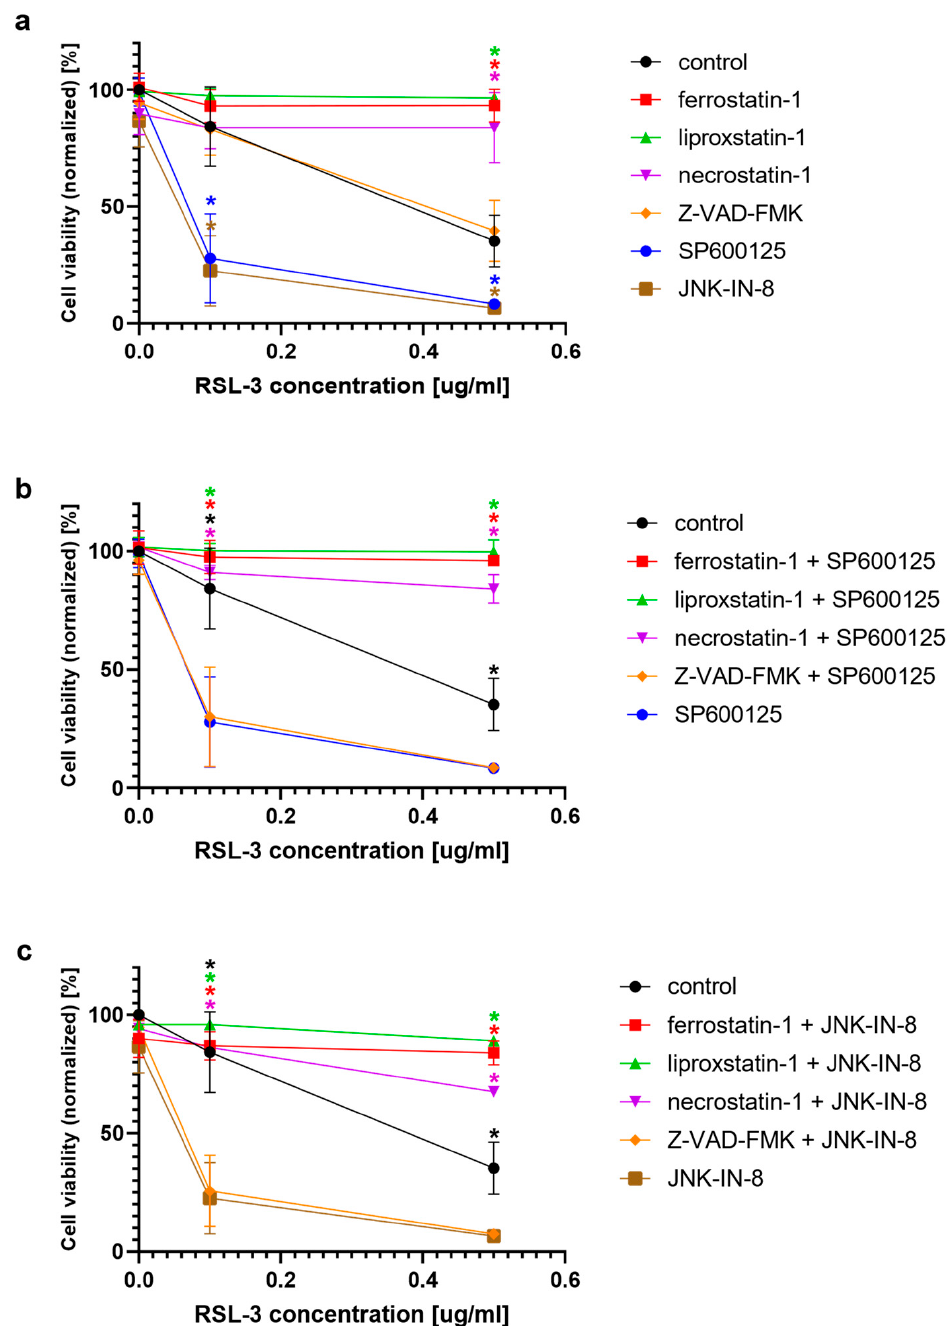
Figure 2. The potential effect of the inhibitors in alleviating cell death induced by RSL-3 in the presence or absence of the JNK inhibitors. HT-1080 cells were treated on a 96-well plate for 24 h with the ferroptosis-inducing compound RSL-3 (0.1 µ g/mL and 0.5 µ g/mL) in the presence or absence of inhibitors of interest and combinations of them: ferrostatin-1 (5 µ M), liproxstatin-1 (500 nM), necrostatin-1 (50 µ g), Z-VAD-FMK (50 µ g), JNK-IN-8 (10 µ g) and SP600125 (5 µ g). Ferroptosis inhibitors, ferrostatin-1, liproxstatin-1, and necroptosis inhibitor necrostatin-1, inhibit RSL-3 induced ferroptosis both in the presence or absence of the JNK inhibitors, while the apoptosis inhibitor, Z-VAD-FMK, has no effect in either case. Cell viability was measured by MTT assay. Data are normalized to the untreated control, and each data point represents the average ± SD from at least three independent experiments. ( a ) * Significantly different ( p < 0.05) from group control (RSL-3 treated without co-treatment). ( b ) * Significantly different ( p < 0.05) from RSL-3 and JNK-IN-8 co-treated. ( c ) * significantly different ( p < 0.05) from RSL-3 and SP600125 co-treated.